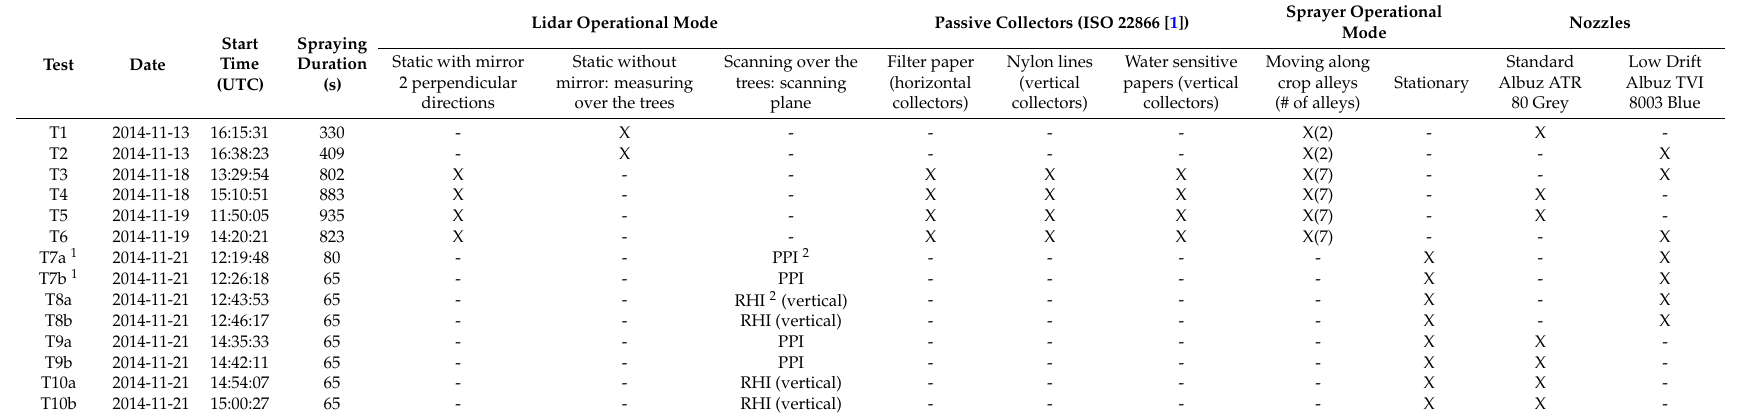
Table 1. Experimental field